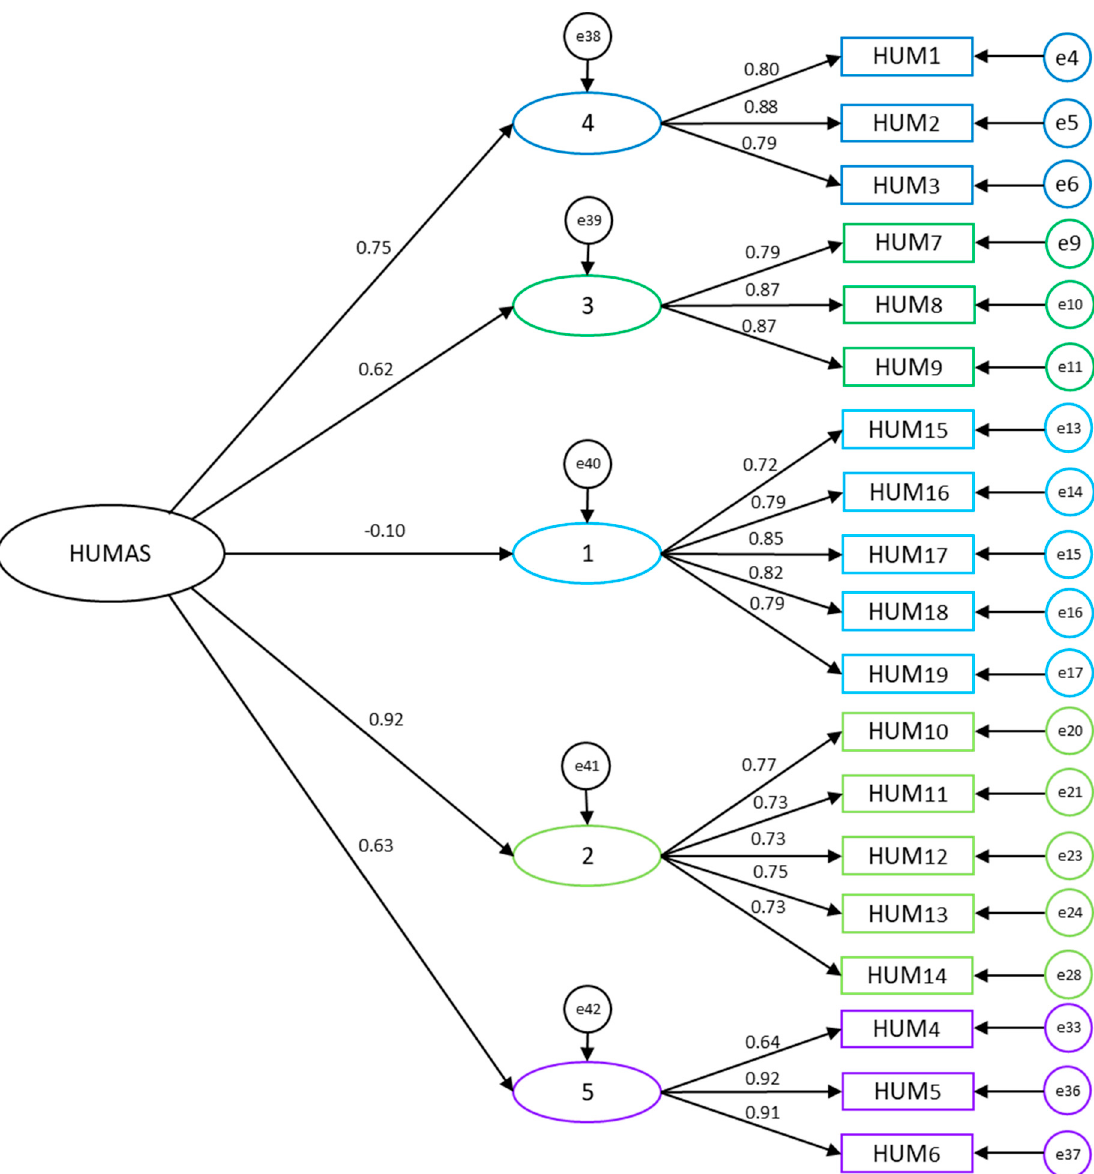
Figure 3. Proposed HUMAS Model with GF (n = 330). Note: F1: Affection; F2: Self-efficacy; F3: Emotional understanding; F4: Optimistic disposition; F5: